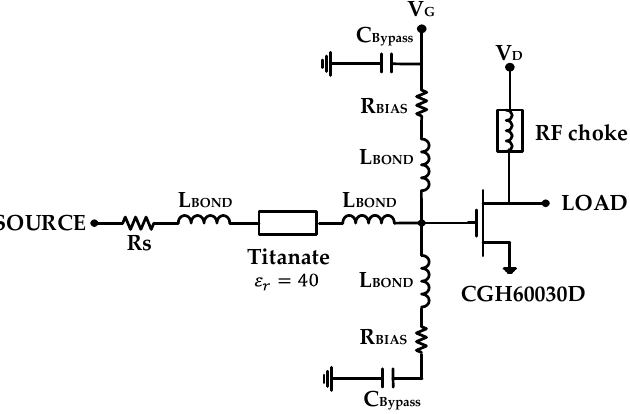
Figure 3. GaN HEMT with the stabilization circuit of the series and shunt resistors.